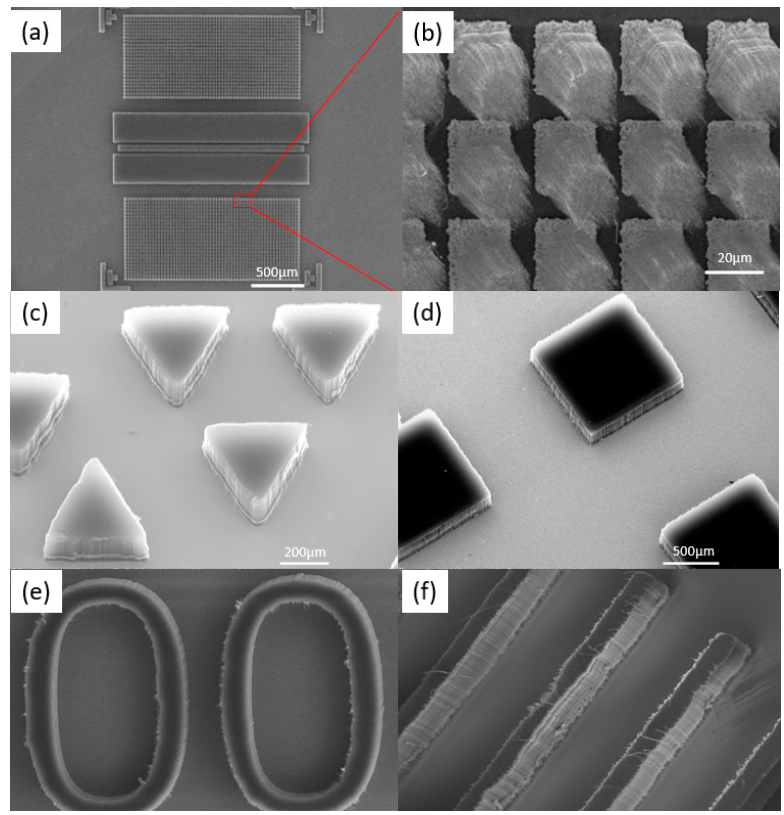
Figure 3. ( a , b ) Transferred CNT with bump size of 25 µm and a pitch of 10 µm with surrounding bumps; ( c – f ) multiple shapes of transferred CNT—for ( e ) and ( f ) the width of the CNTs patterns are 200 µm and the height of the CNT 500 µm.